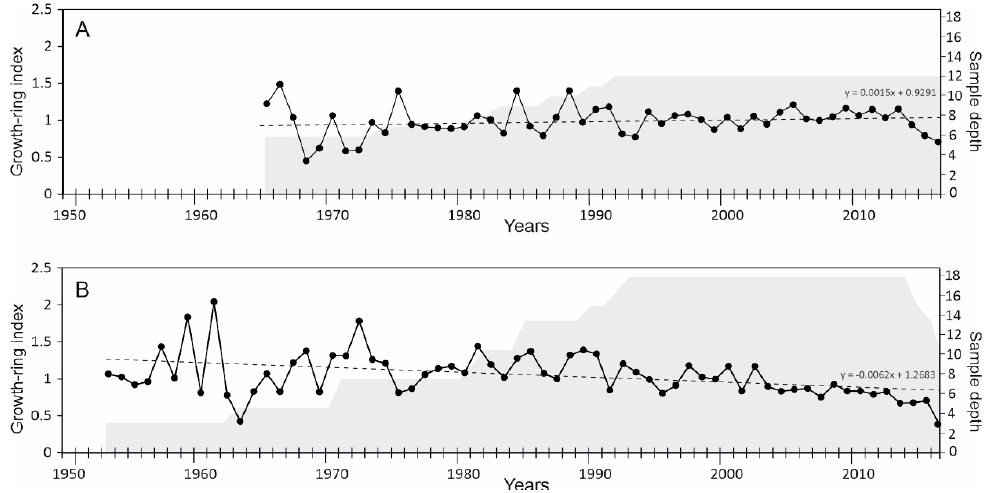
Figure 4. Indexed growth ring chronologies of dwarf willow from ( A ) the Mýrdal site and ( B ) the Afrétt